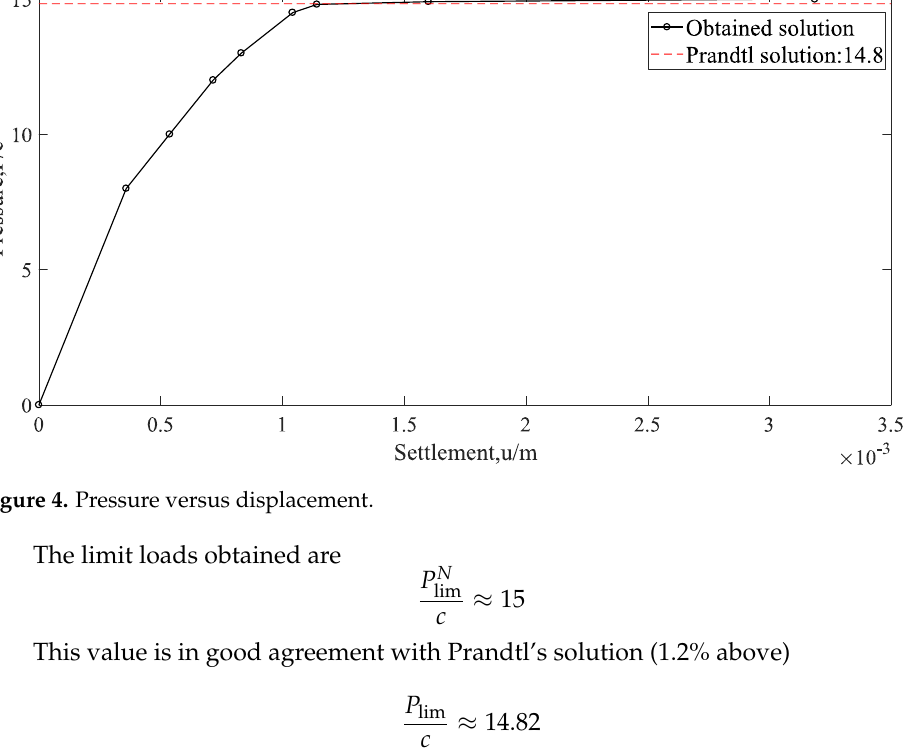
Figure 3. Strip footing: ( a ) problem geometry; ( b ) adopted mesh.